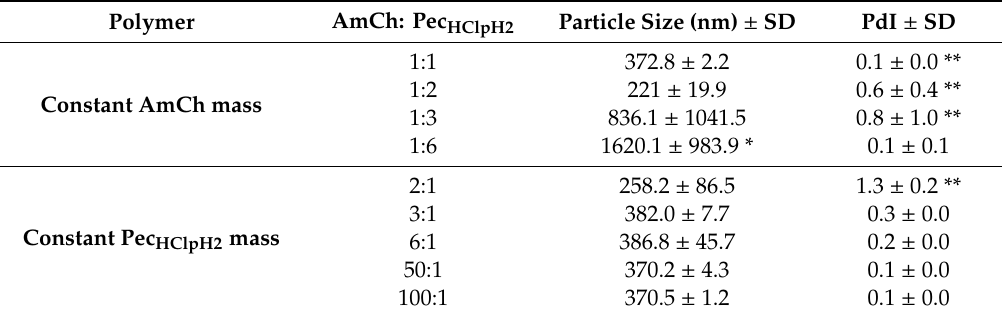
Table 3. E ff ect of mass ratio of AmCh:Pec HClpH2 on the particle size and PdI of the polyelectrolyte nanoparticles.